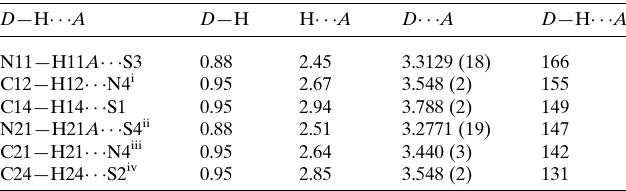
Table 3 Hydrogen-bond geometry (A˚ , (cid:3) ) for 1